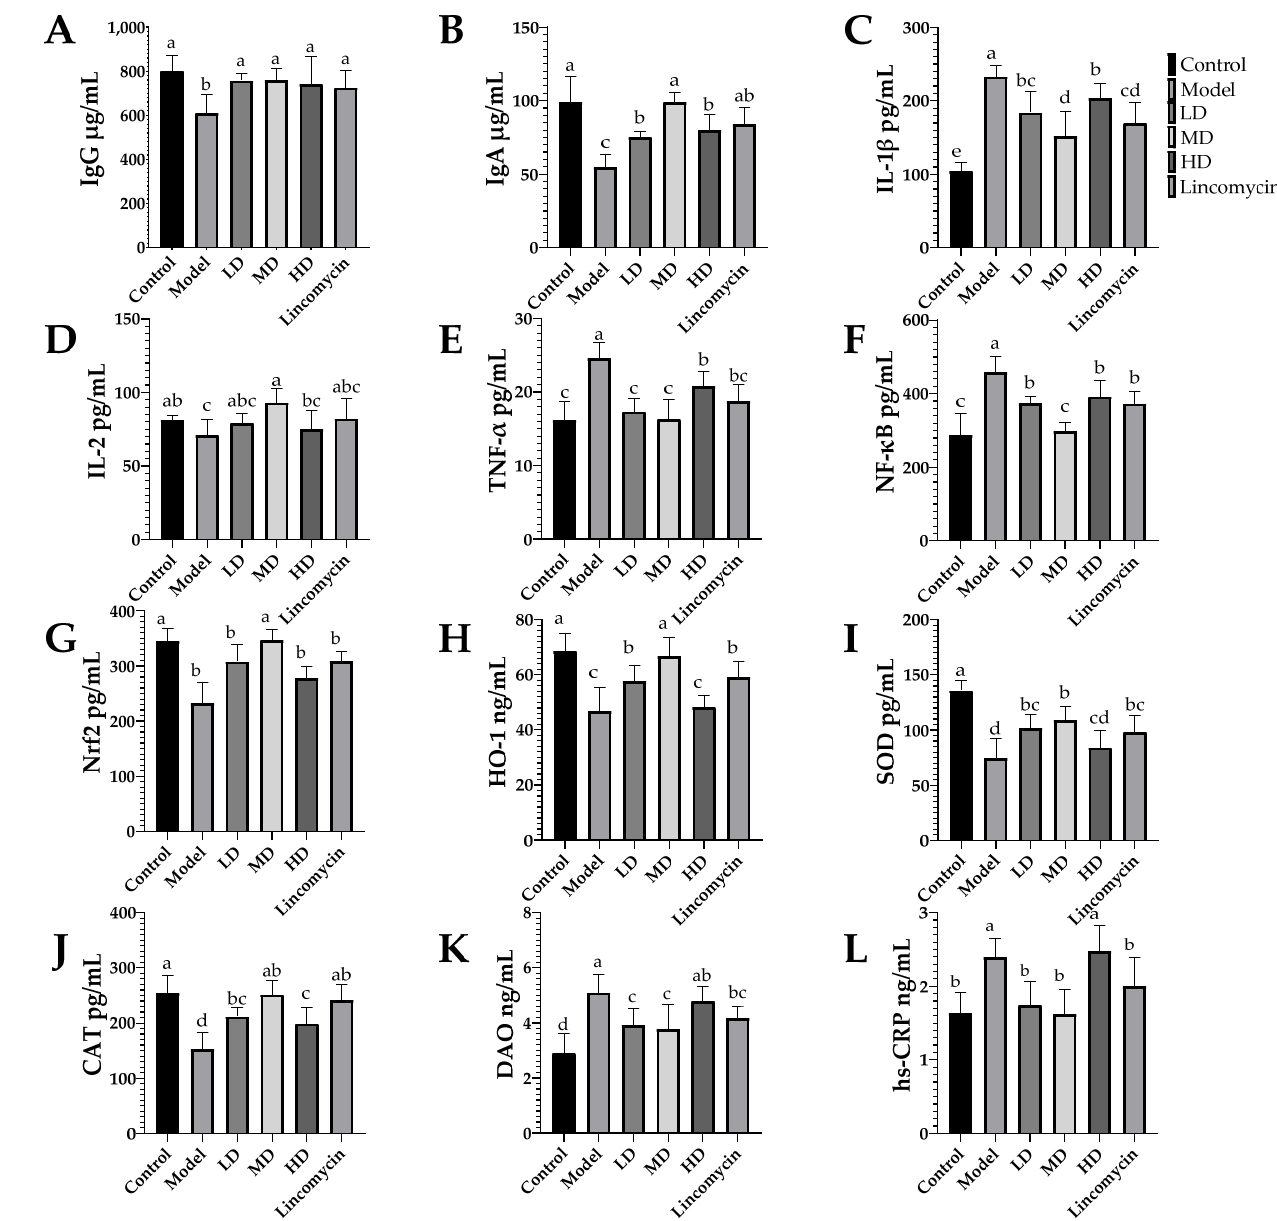
Figure 6. Serum concentrations of immunoglobulins, inflammatory factors, and antioxidant factors. ( A ) Immunoglobulin G (IgG); ( B ) immunoglobulin A (IgA); ( C ) interleukin 1 beta (IL-1 β ); ( D ) interleukin 2 (IL-2); ( E ) tumor necrosis factor alpha (TNF- α ); ( F ) nuclear factor kappa B (NF- κ B); ( G ) nuclear factor erythroid 2-related factor 2 (Nrf-2); ( H ) heme oxygenase 1 (HO-1); ( I ) superoxide dismutase (SOD); ( J ) catalase (CAT); ( K ) diamine oxidase activity (DAO); ( L ) C-reactive protein (CRP). Values with the same superscript letters in the same line were not significantly different ( p > 0.05); values with different letters were significantly different ( p < 0.05).